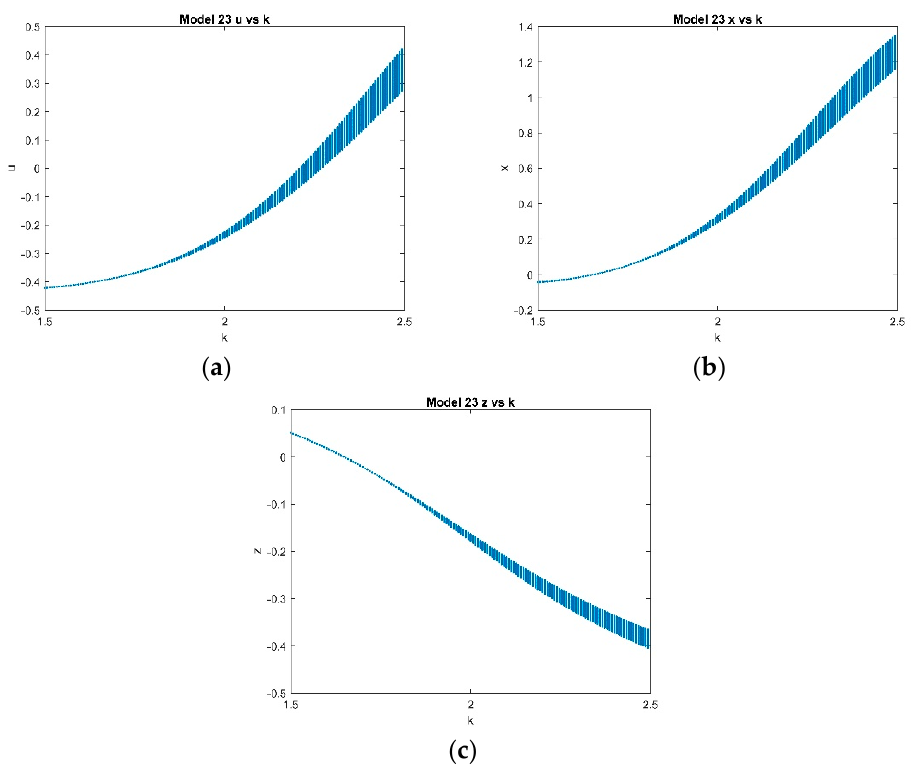
Figure 20. ESDDFD1 model (23); ( a ) u vs. k , ( b ) x vs. k , ( c ) z vs. k , at p = 1, α 5 = 0.3, k ∈ [ 1.5, 2.5 ] .